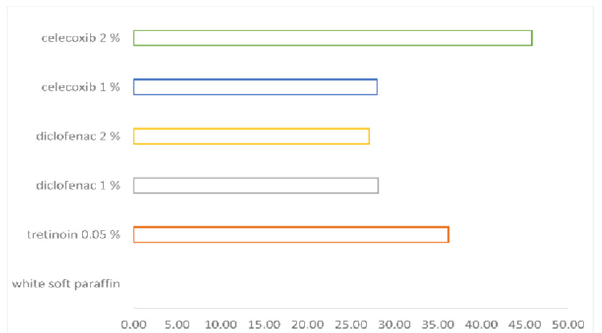
Figure 5. The percentual drug activity.